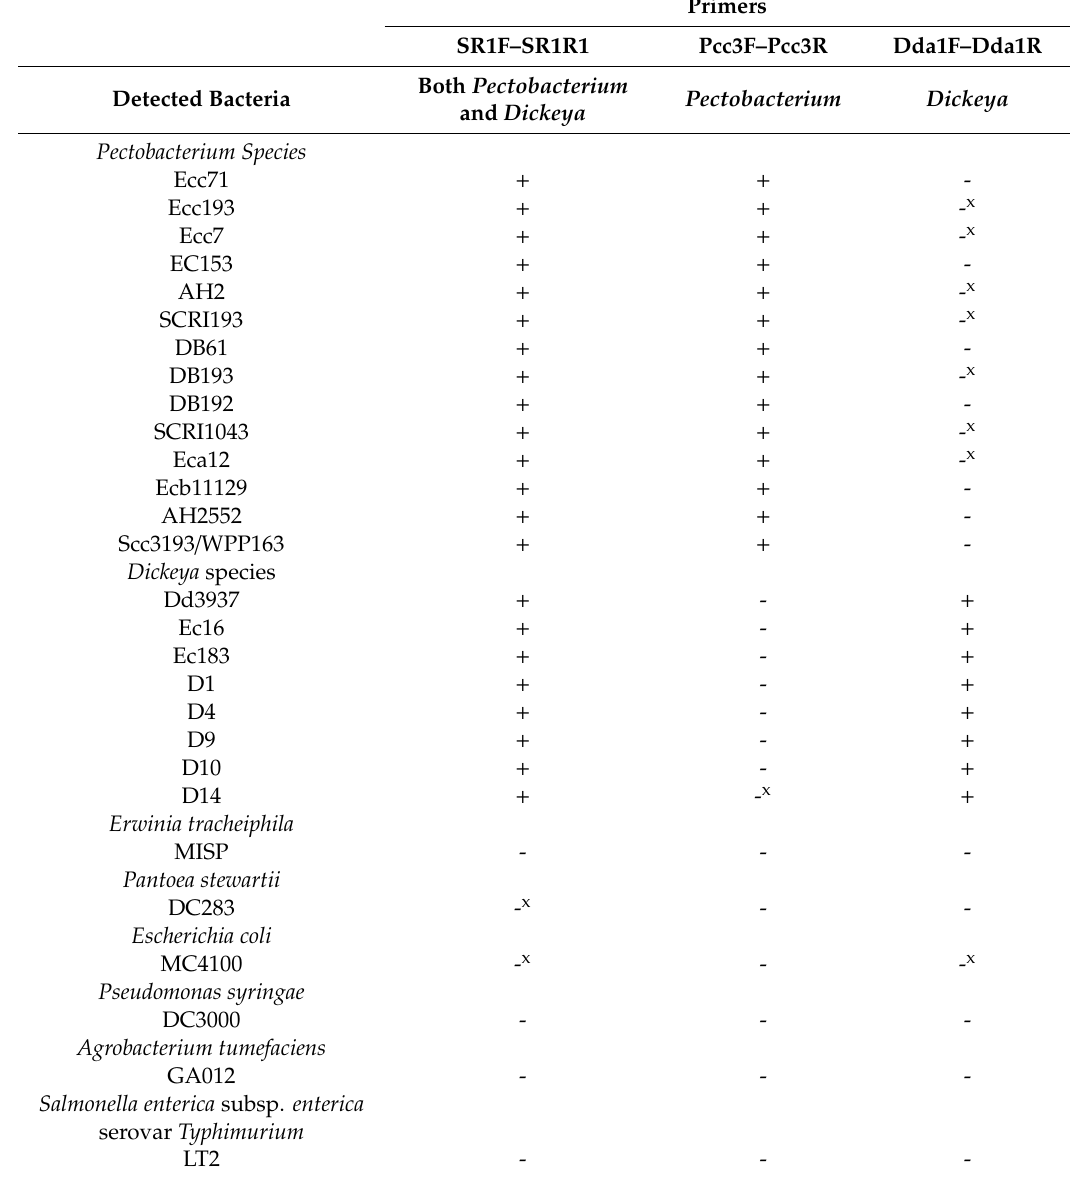
Table 2. PCR amplification with primers developed in this